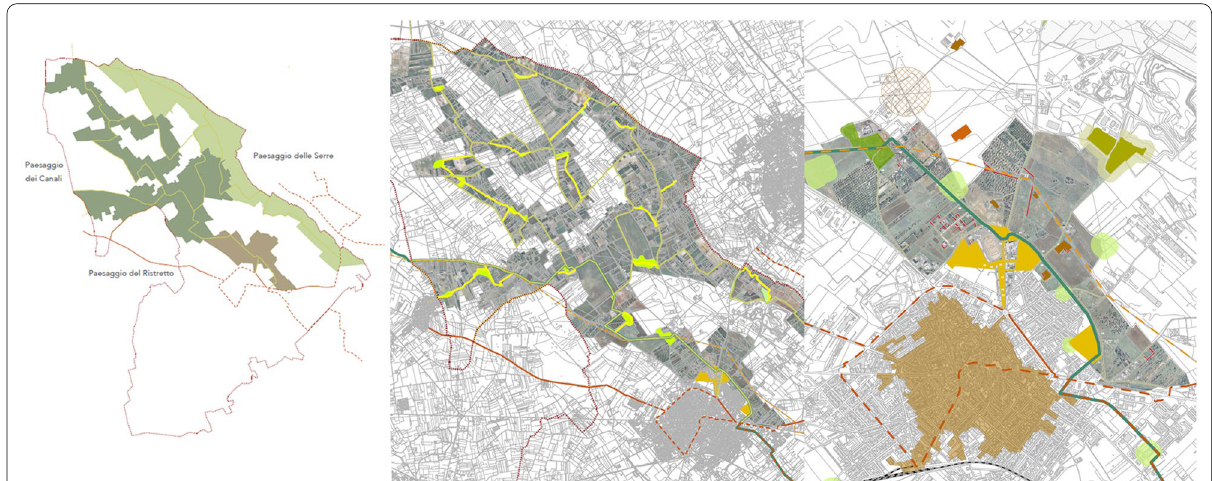
Fig. 4 The strategy of Negramaro Multifunctional Agricultural Park. The City-Country Pact strategy on the left identifies 3 areas for enhancing the Negramaro Park (left) linked to hydrological and environmental invariants and orography. By utilising and naturalising abandoned areas (centre), the strategy aims to enhance the wine production system, interacting with the peri-urban space (right). Source: Municipality of Campi Salentina, extracts from table 15 (original content scale 1:20,000, north–south oriented) and table 18 (original content scale 1:10,000, north–south oriented) of the Adaptation of the Municipal Plan to the PPTR (2019)